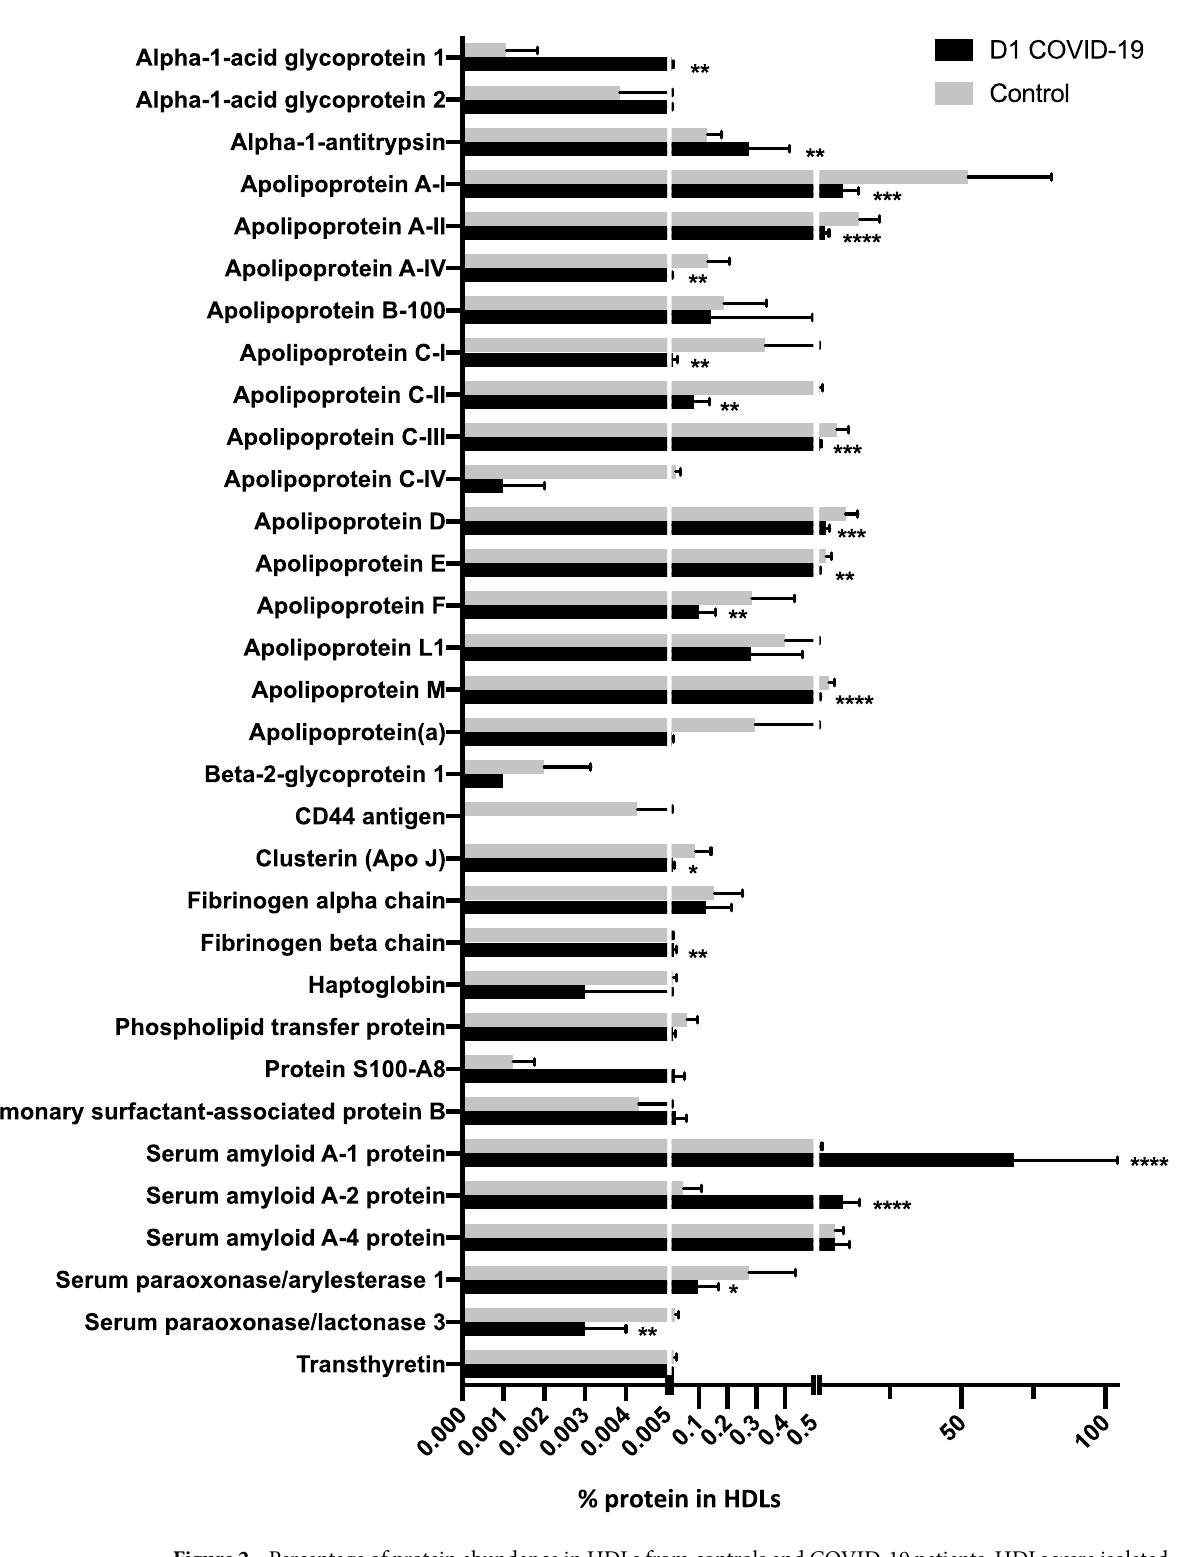
Figure 2. Percentage of protein abundance in HDLs from controls and COVID-19 patients. HDLs were isolated from the plasma of 15 controls and 8 patients with COVID-19 at admission (D1). Bar graphs represent the percentage of intensity ± SD of the two groups. Unpaired t-test was used. * p < 0.0332, ** p < 0.0021, *** p < 0.0002 and **** p < 0.0001 as compared to the control